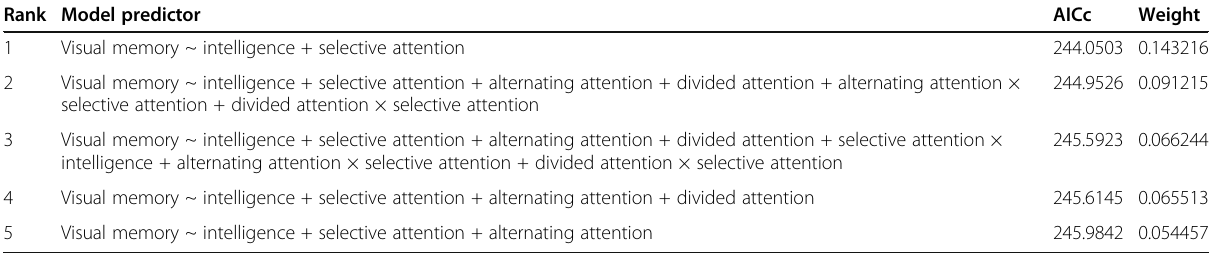
Table 3 Top ranked predictors of visual short-term memory results Rank Model predictor